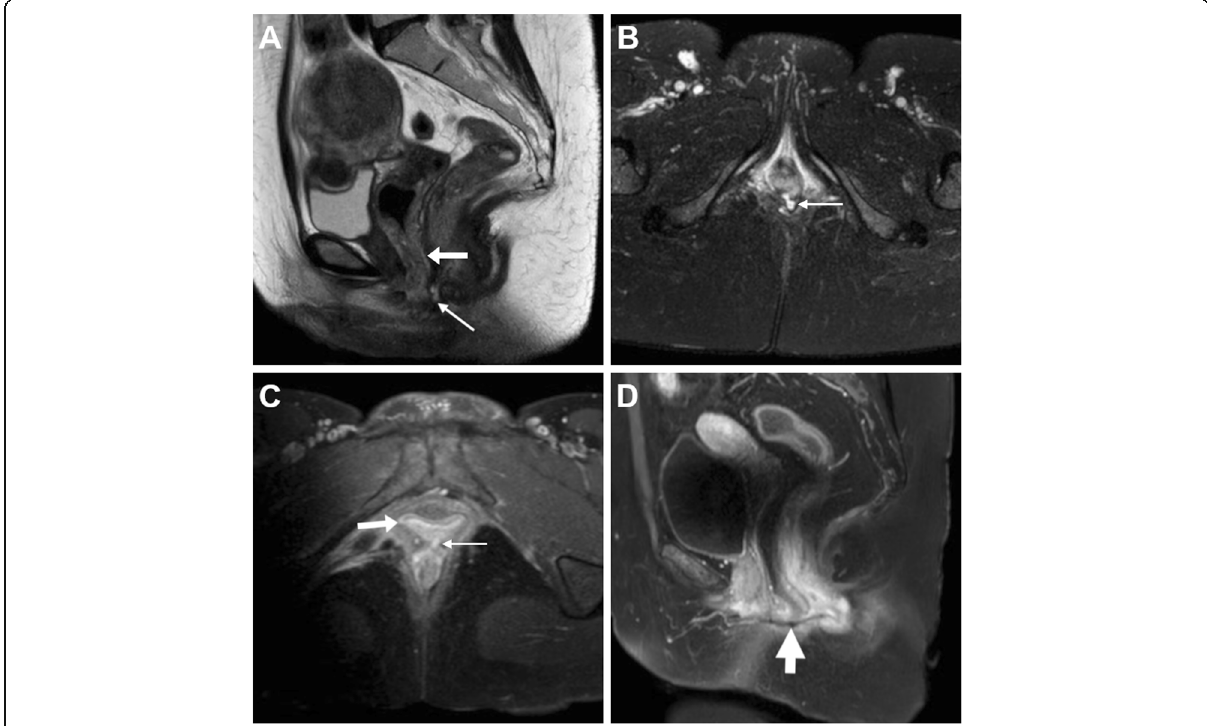
Fig. 10 MRI of uncomplicated perianal Crohn ’ s disease (CD). a , b in a 41-year-old, the ano-VF is seen as a midline fluid-filled track (thin arrows) coursing through the anovaginal septum to reach the lower third of the vagina (arrow) on sagittal ( a ) and FS axial ( b ) T2-weighted images. c , d in a 36-year-old with colonic CD, the ano-VF is initially seen as a thin midline tract (thin arrow) on axial FS T1-weighted image after gadolinium CM ( c ) that reaches the vagina (arrow). On infliximab, repeated MRI including sagittal FS T1-weighted image after gadolinium CM ( d ) shows positioning of a seton (thick arrow) through the